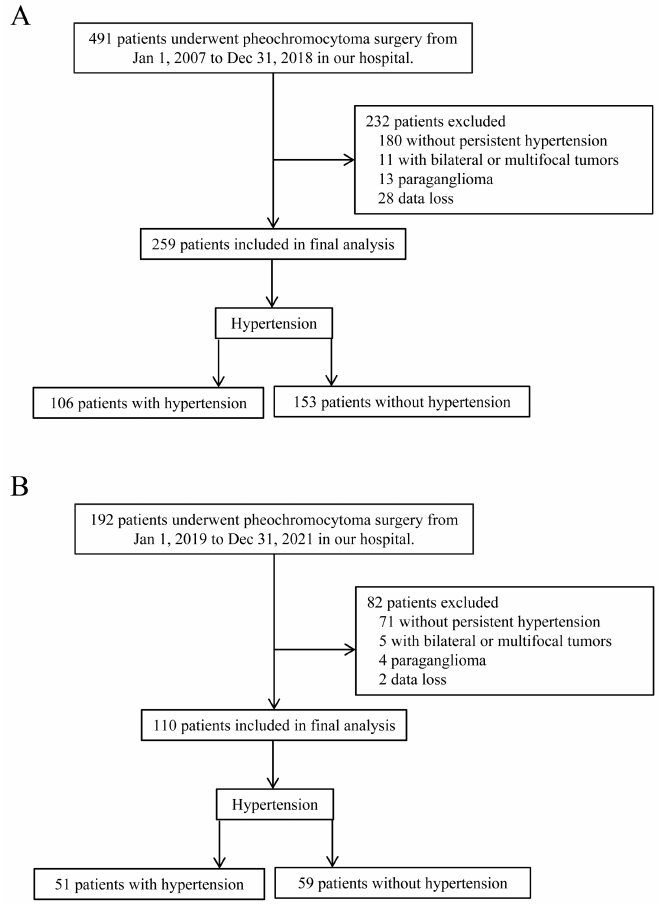
Figure 1. Flowchart of study. ( A ): Inclusion and exclusion flow chart of development cohort; ( B ): Inclusion and exclusion flow chart of validation